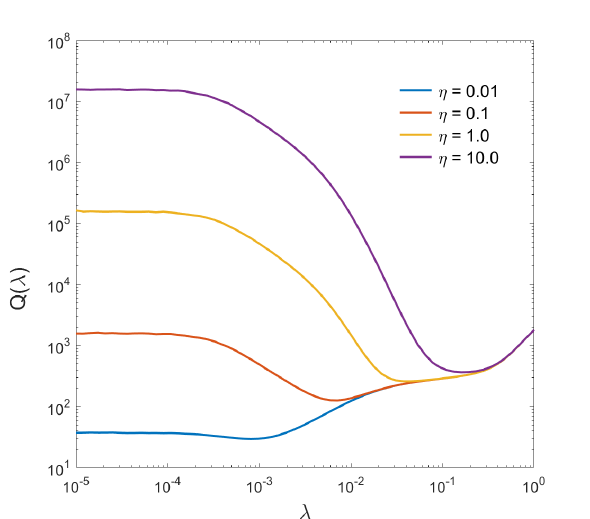
Figure 3. Deblur error for different levels of input